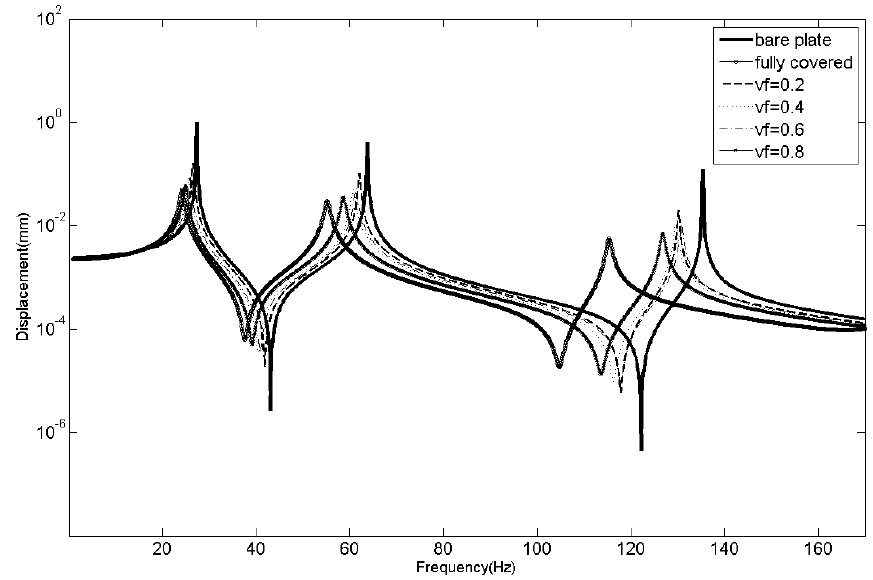
Fig. 26. Frequency response at the center of the plate excited by unit harmonic force at the same point.